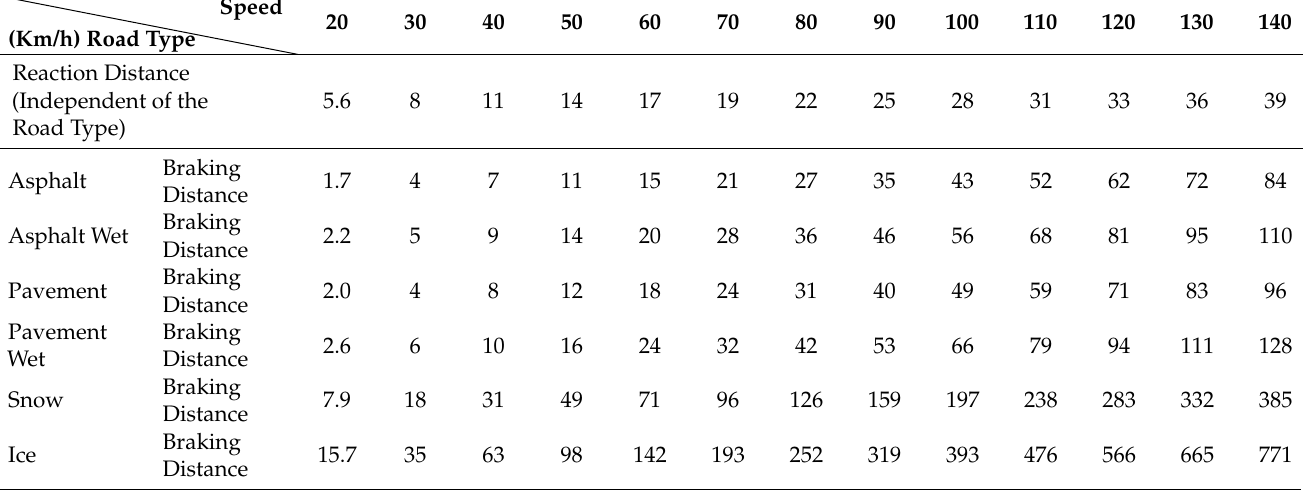
Table 4. Stooping Distance for different road types for different speeds. Reaction distance is not affected by the road